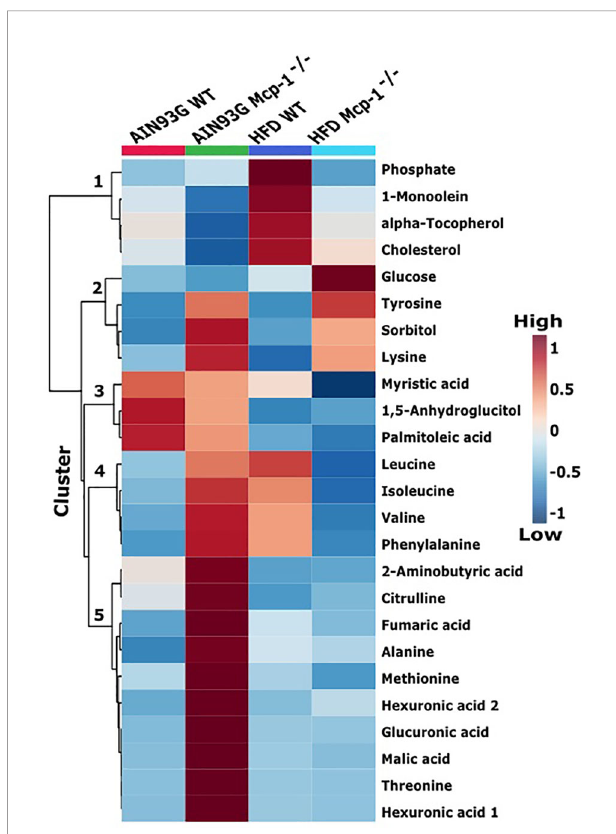
FIGURE 4 | Hierarchical clustering heatmap of the top 25 plasma metabolites that differ among the four dietary groups. AIN WT (red): wild-type mice fed the AIN93G diet; AIN Mcp-1 -/- (green): Mcp-1 -/- mice fed the AIN93G diet; HFD WT (blue): wild-type mice fed the high-fat diet; HFD Mcp-1 -/- (cyan): Mcp-1 -/- mice fed the high-fat diet. Each cell on the map represents the group average of a metabolite (n = 10 per